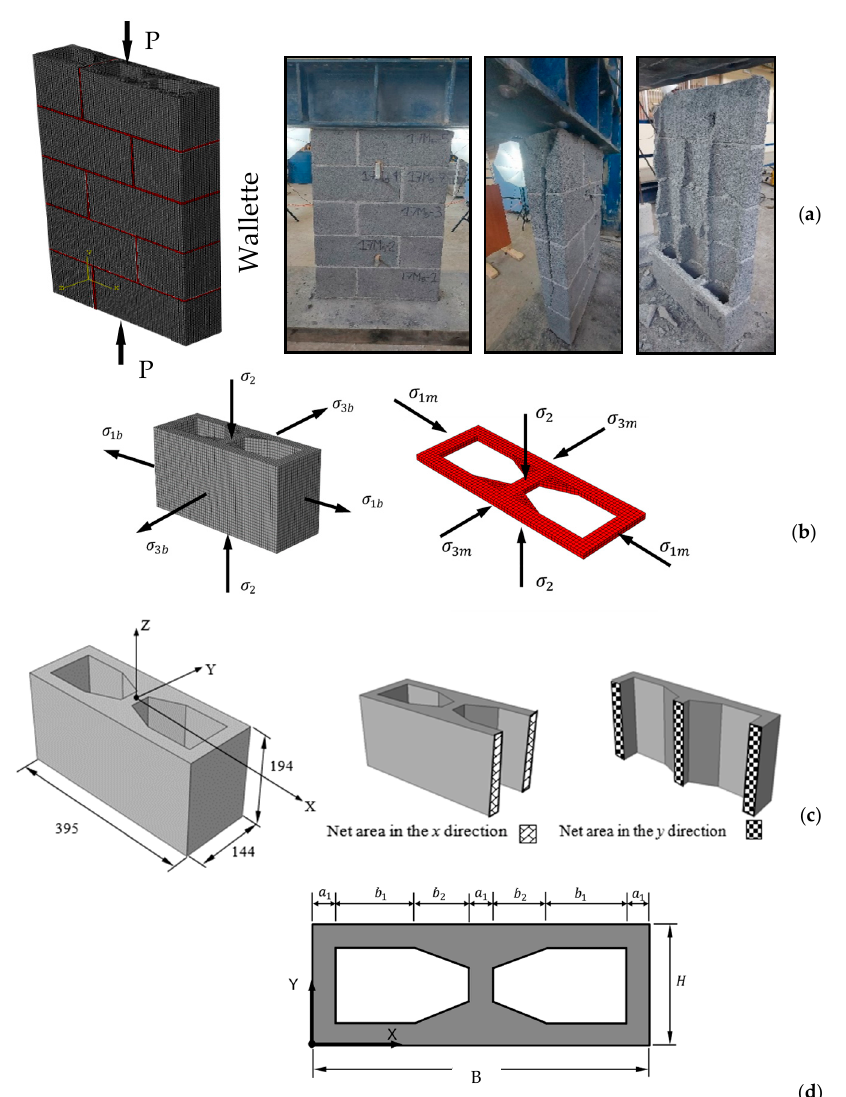
Figure 2. ( a ) Failure patterns of HCB masonry in wallets under compressive stresses. ( b ) Stress state induced in the HCB and the mortar due to the different deformation characteristics of both materials. ( c ) Different types of net areas in the HCB (the dimensions are in mm). ( d ) Geometric parameters of the HCB (the mean values of these dimensions are in Table 2); the depth of the HCB is called Z.